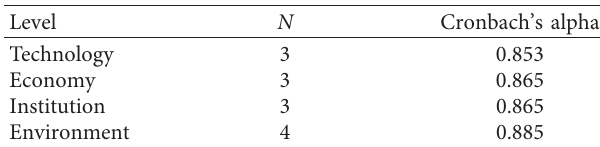
Table 4: Reliability